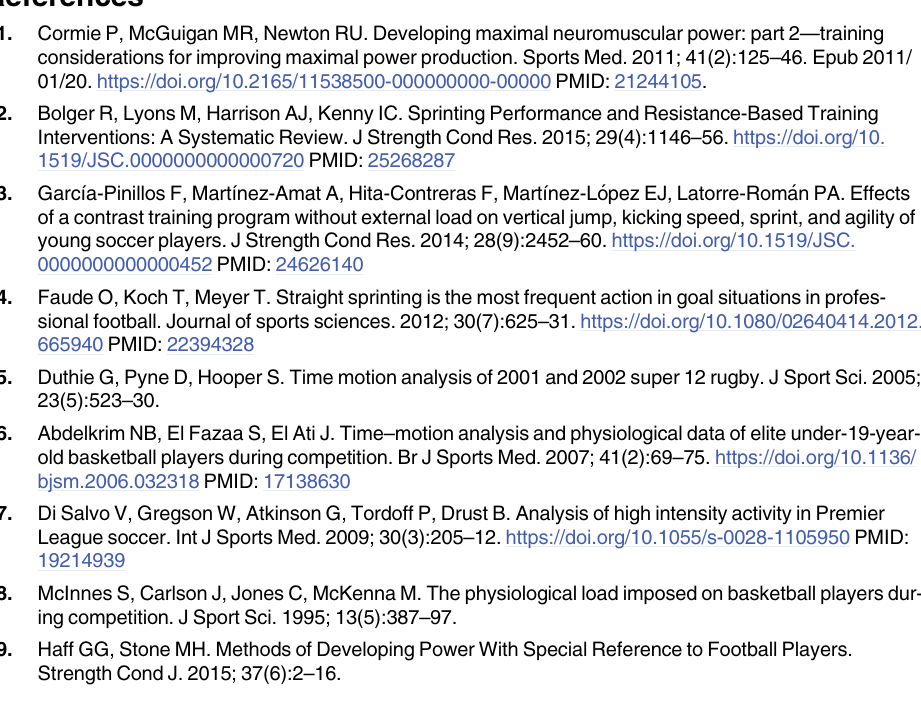
S1 Table. PRISMA